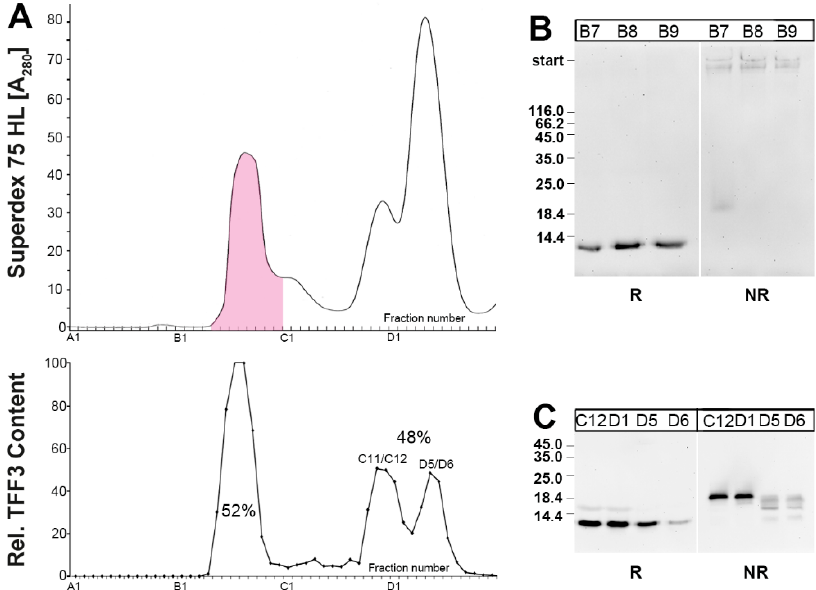
Figure 1. Analysis of human saliva from a single individual (S-23). ( A ) Elution profile after SEC on a Superdex 75 HL column as determined by absorbance at 280 nm. Fractions positive after PAS staining are shown in pink. Underneath: Distribution of the relative TFF3 content in the fractions as determined by Western blot analysis under reducing conditions and semi-quantitative analysis of the typical 7k-band intensities (TFF3 monomer). ( B ) 15% SDS-PAGE and subsequent Western blot analysis of the high-molecular-mass fractions B7-B9. Samples were analyzed under reducing (R) and non-reducing conditions (NR), respectively, for their TFF3 immunoreactivity. The molecular mass standard is indicated on the left. ( C ) 15% SDS-PAGE and subsequent Western blot analysis of low-molecular-mass fractions C12 / D1 and D5 / D6. Samples were analyzed under reducing (R) and non-reducing conditions (NR), respectively, for their TFF3 immunoreactivity. The molecular mass standard is indicated on the left.